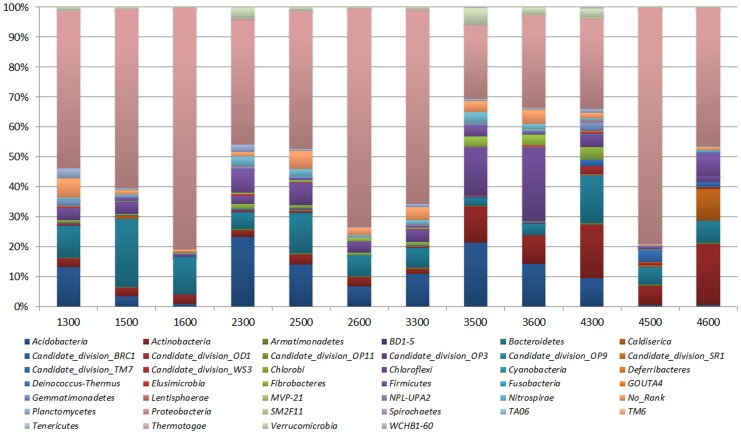
Bacterial composition of the different communities at the phylum level.Relative read abundance of different bacterial phyla within the different communities. Sequences that could not be classified into any known group were assigned as No_Rank.